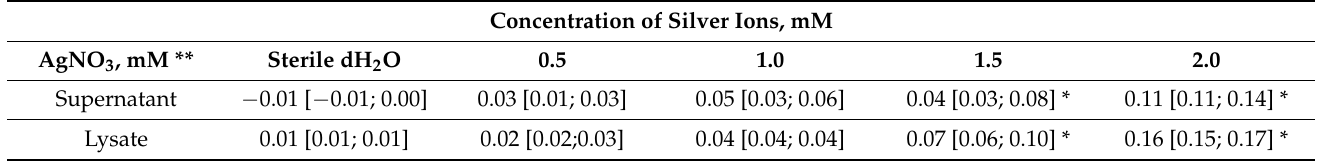
Table 1. Final concentration of silver ions in the sample solution. Concentration of Silver Ions,